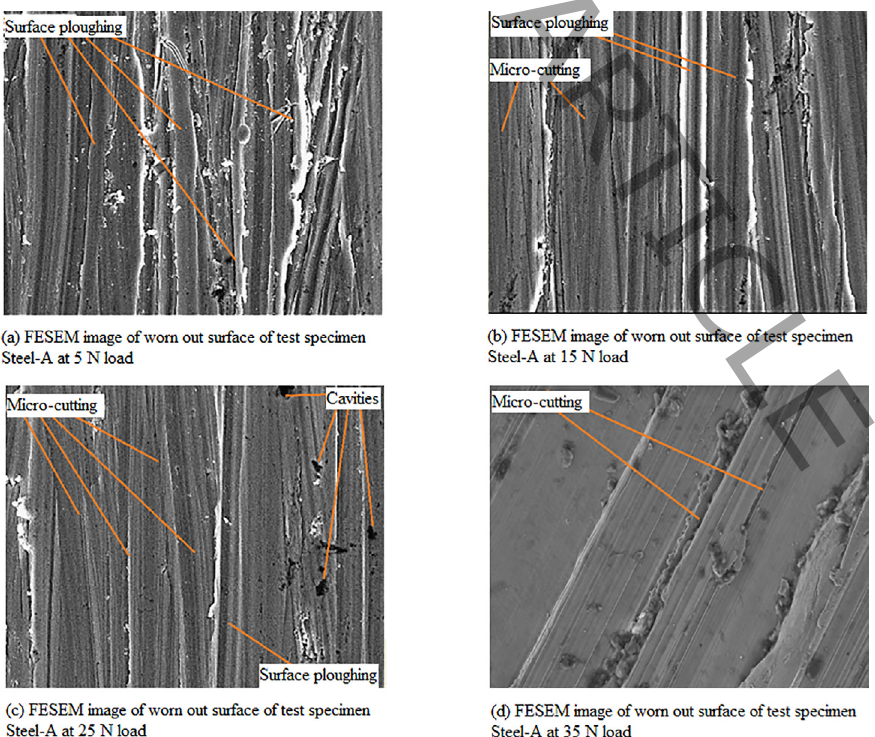
Figure 3. Field emission scanning electron microscope images of worn out surface of Steel-A test specimen at: (a) 5 N, (b) 15 N, (c) 25 N and (d) 35